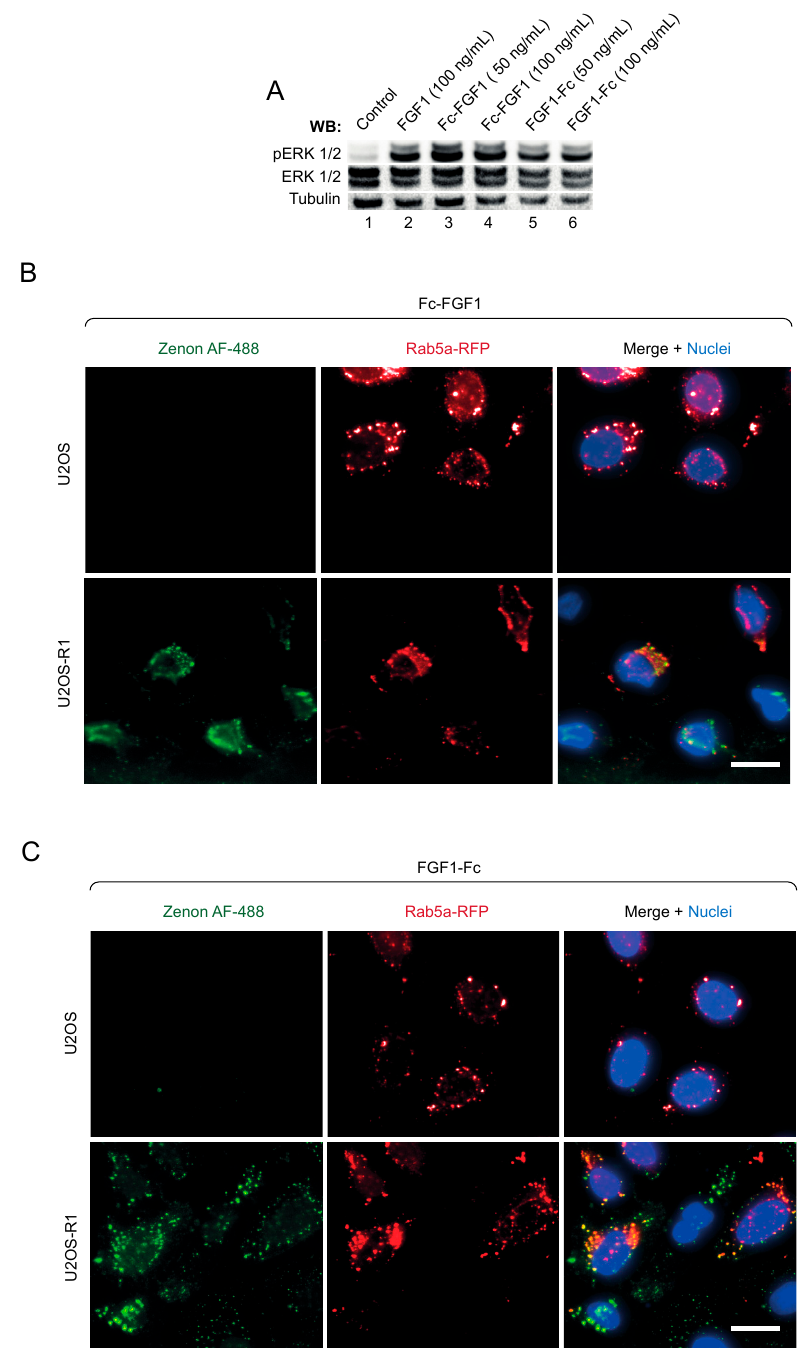
Figure 4. Biological activity of FGF1 fused to Fc fragment. ( A ) Serum-starved NIH3T3 cells were incubated for 15 min with FGF1, as a control, Fc-FGF1 or FGF1-Fc. Proteins were added in the presence of heparin (10 U/mL). Cells were lysed and the activation of receptor downstream ERK1/2 signaling was assessed with Western blotting (with antibodies recognizing phosphorylated ERK1/2 (pERK1/2)). The level of tubulin served as a loading control. ( B , C ) FGFR1-mediated internalization of FGF1 variants. U2OS (control) and U2OS-R1 cells were incubated with Fc-FGF1 ( B ) or FGF1-Fc ( C ) for 30 min at 37 °C. Nuclei were stained with NucBlue Live, and early endosomes were labeled by cell light early endosomes-RFP. Cells were fixed, and internalized recombinant proteins were visualized with Zenon AF-488 using the wide-field fluorescence microscope. The scale bar represents 20 μ m.